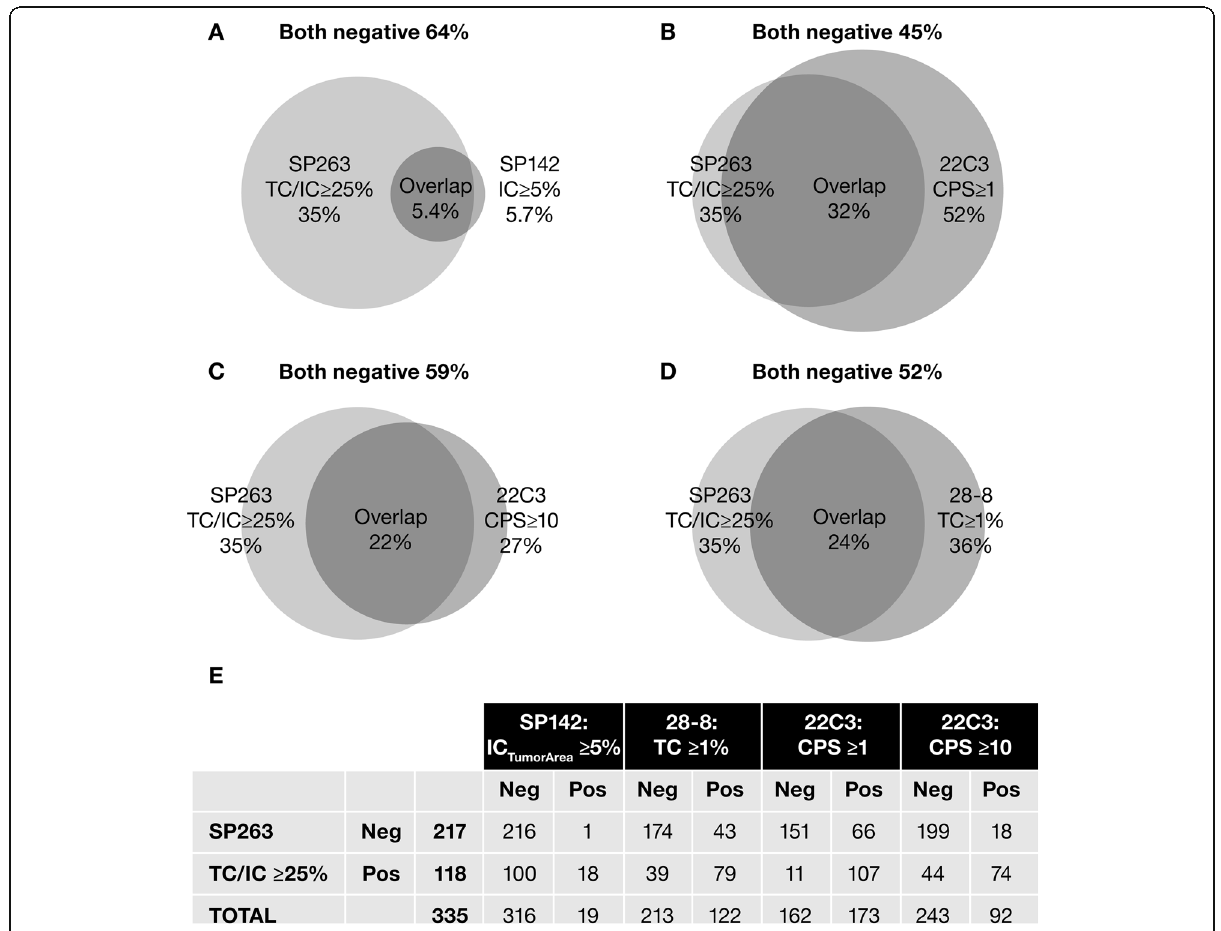
Fig. 4 Differences in the populations selected by the investigated algorithms. a SP263 (TC/IC ≥ 25%) versus SP142 (IC TumorArea ≥ 5%), b PD-L1